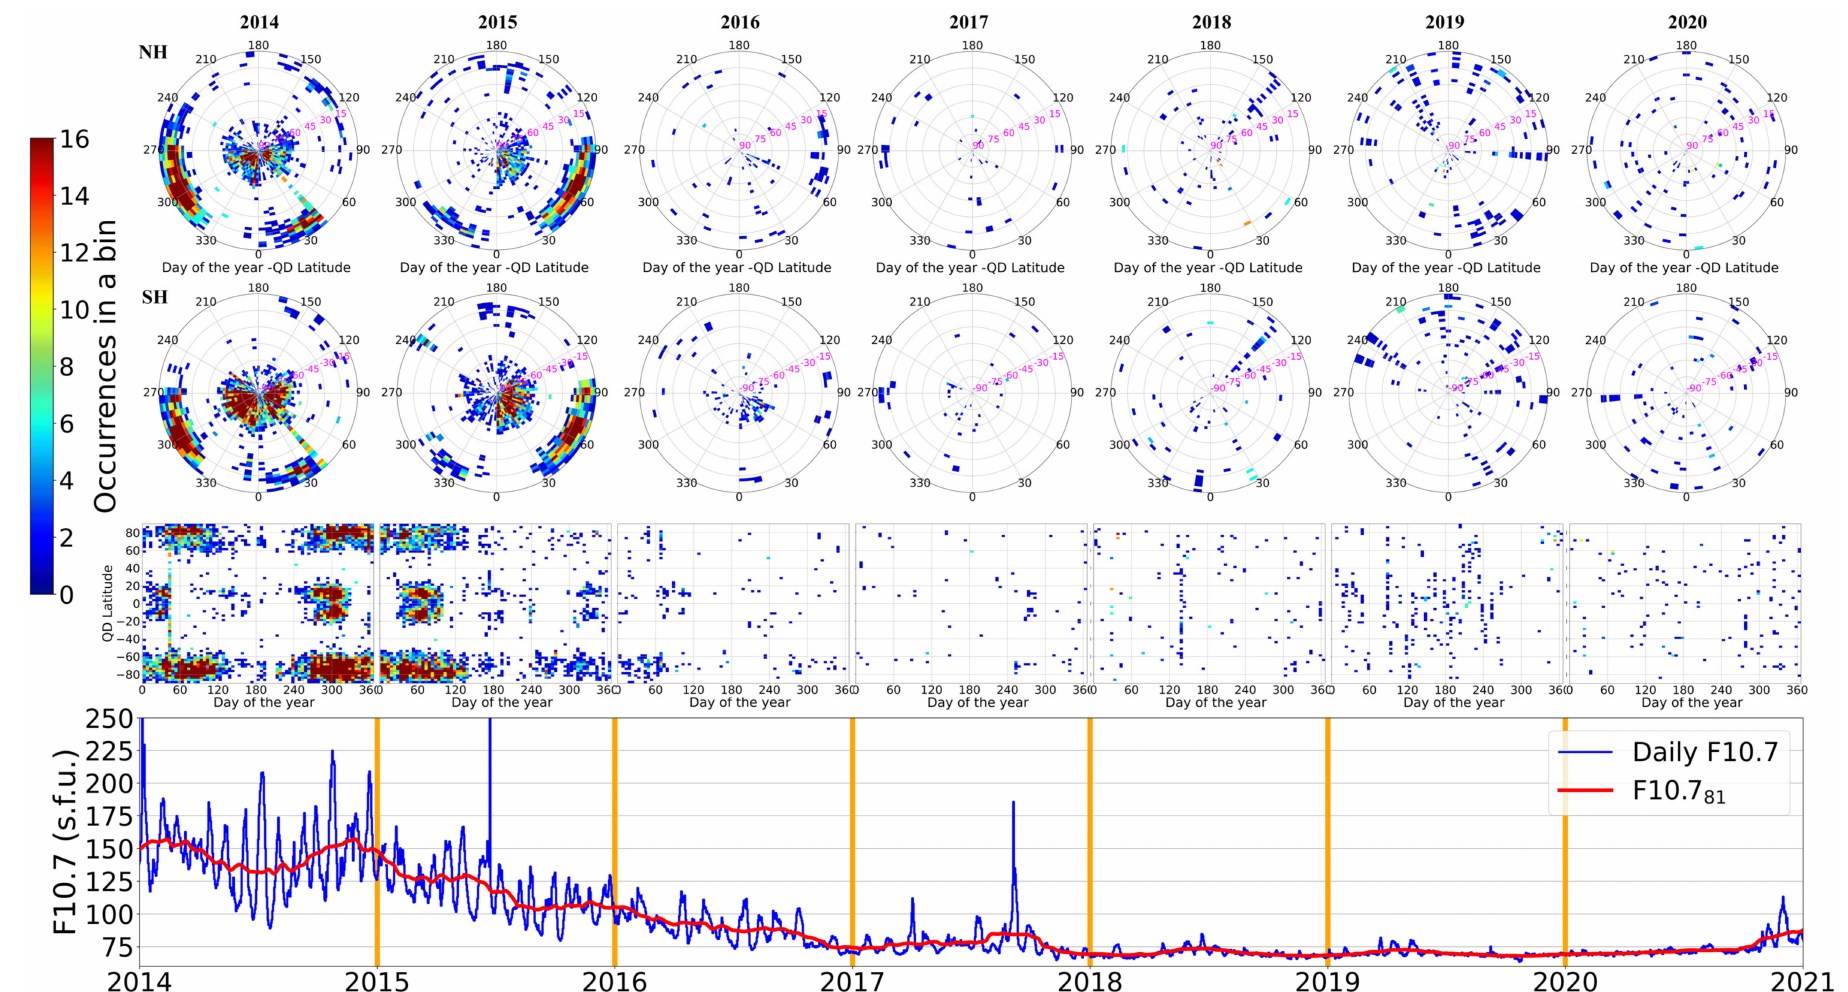
Figure 6. Same as Figure 4 but for each year of the considered dataset, from 2014 to 2020. Polar projection (where the radius is the QD latitude and the azimuth angle is the day of the year) ( first row ) for the Northern hemisphere, ( second row ) for the Southern hemisphere, ( third row ) global projection, ( fourth row ) daily values of the F 10.7 solar index (in blue) and corresponding 81-days running mean F 10.781 (in